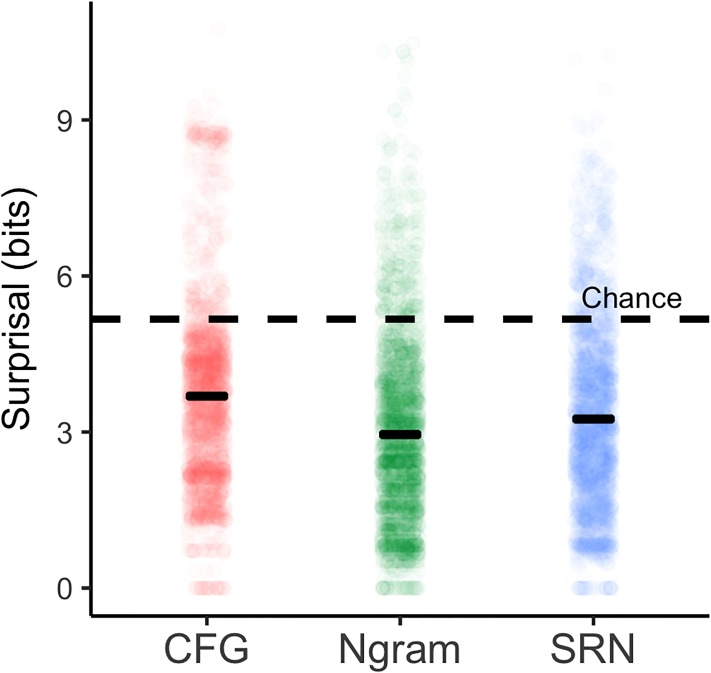
Surprisal distributions from each of three models along with mean surprisal ±1 standard error of the mean (black bars).Surprisal from a model where each POS tag is uniformly probably is indicated with the dashed line.